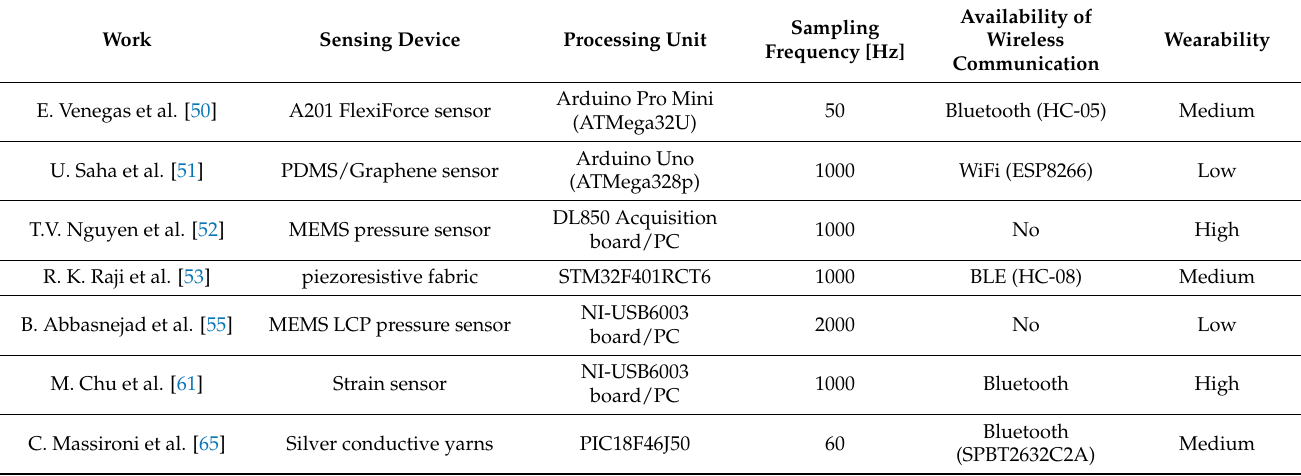
Table 2. Table summarizing the discussed piezoresistive RR sensors from the point of view of the used sensing device, processing unit, sampling rate, availability of wireless communication, and wearability.